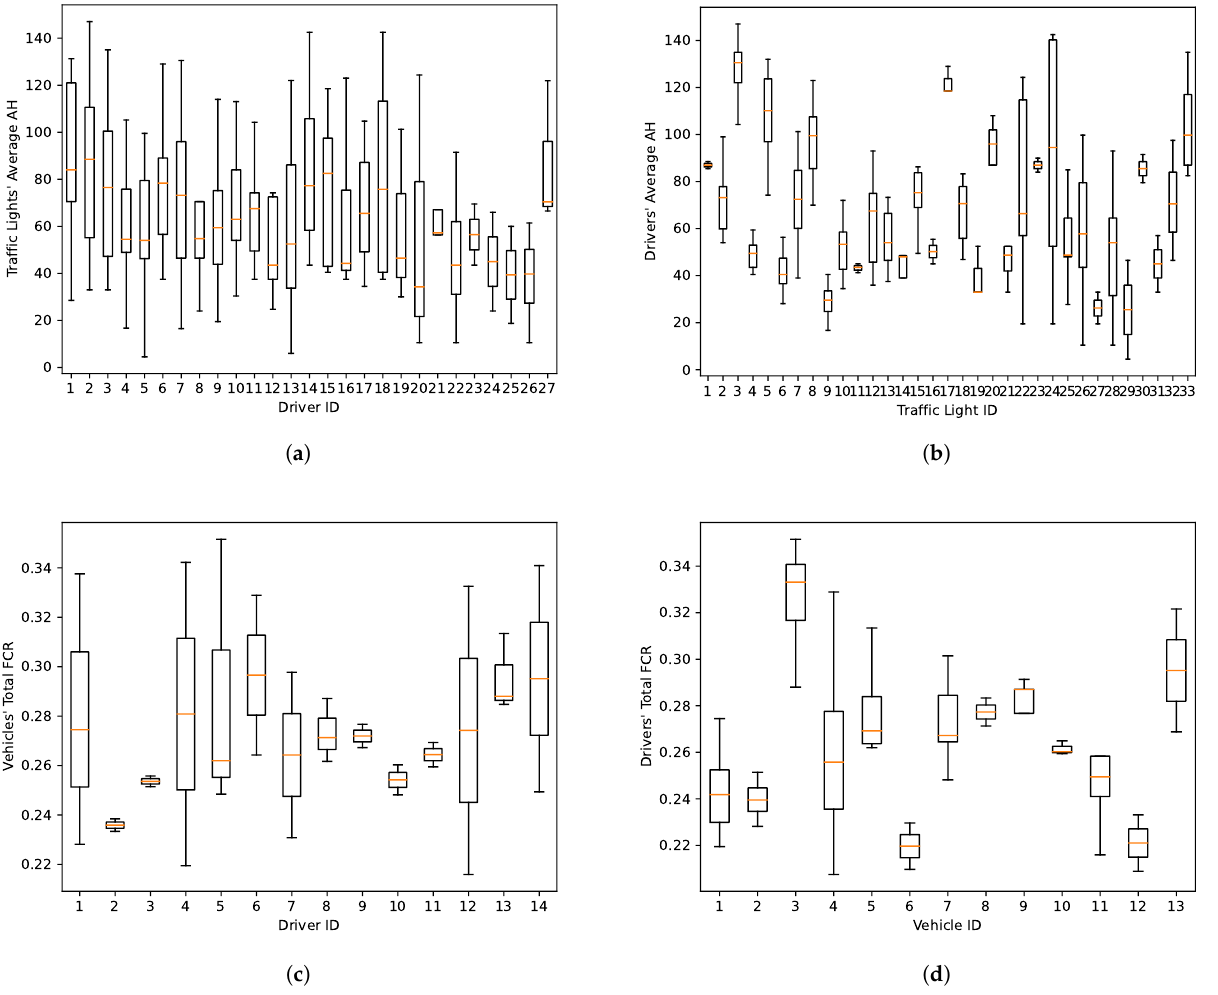
Figure 4. The box plots representing the distributions of ( a ) per traffic light average AHs for each driver, ( b ) per driver average AHs for each traffic light, ( c ) per vehicle FCRs for each driver, and ( d ) per driver FCRs for each vehicle. The box plots for IDs with less than two samples are not shown in this